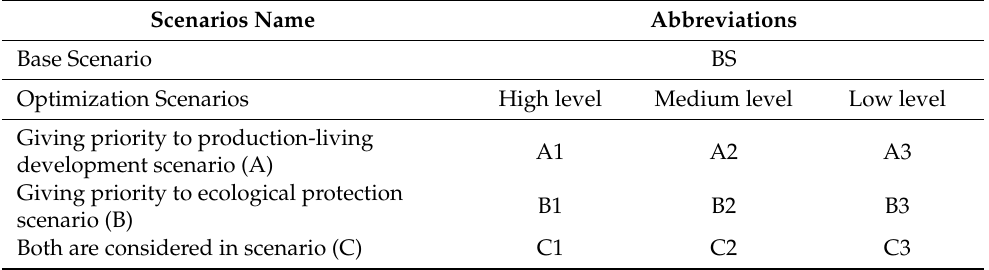
Table 6. Scenario design and solution code.